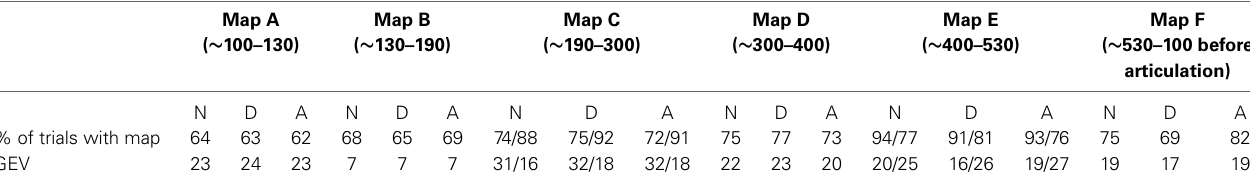
Table 2 | Proportion of map presence and global explained variance for each topographic map in the single trial ERPs ( n = 4797), for each utterance format.